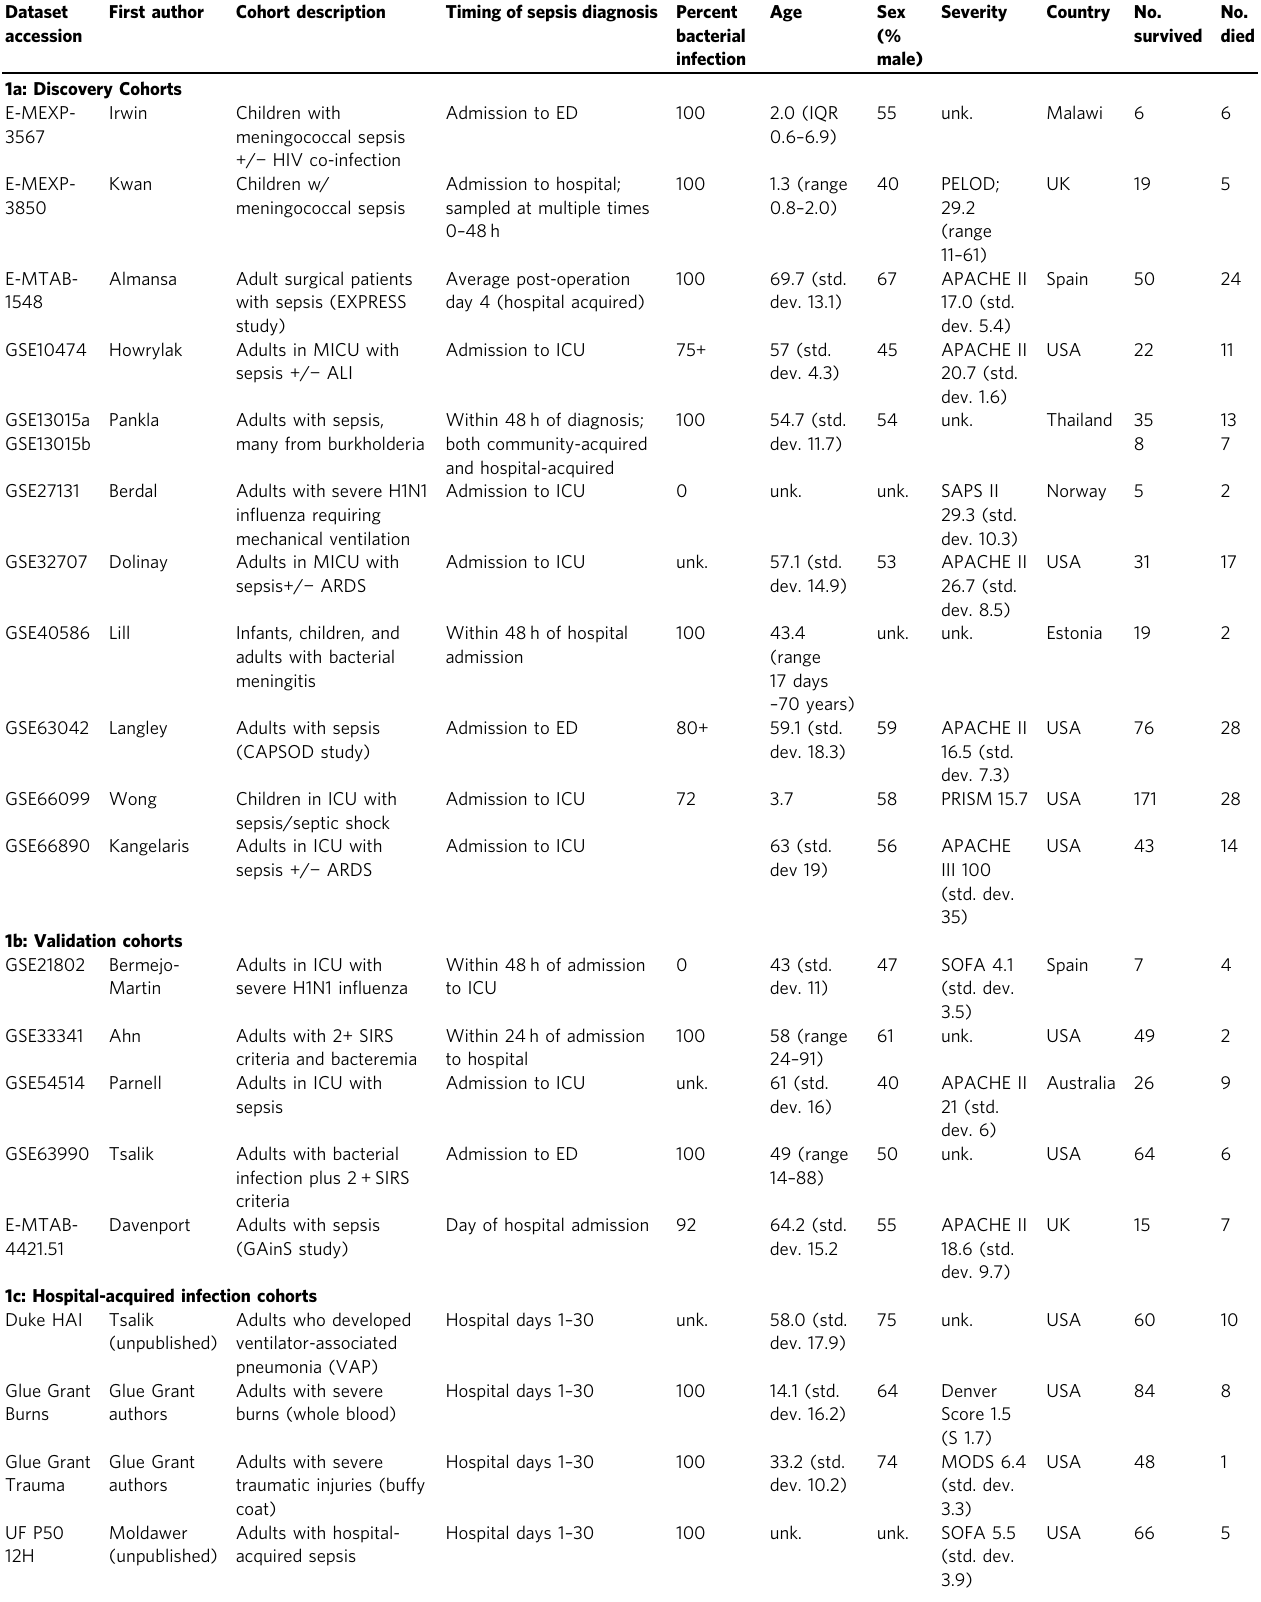
Table 1 Datasets included in the